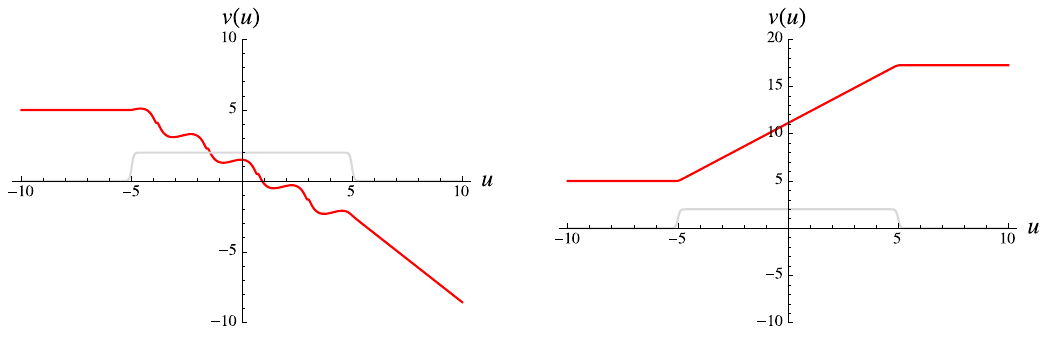
Figure 10 . Plots of the lightcone coordinate v ( u ) through the encounter with a gyraton. The left- hand plot is for relatively small angular momentum J , with the bumpy change in v ( u ) re(cid:13)ecting the number of orbits. The right-hand plot is for bigger J and covers a single